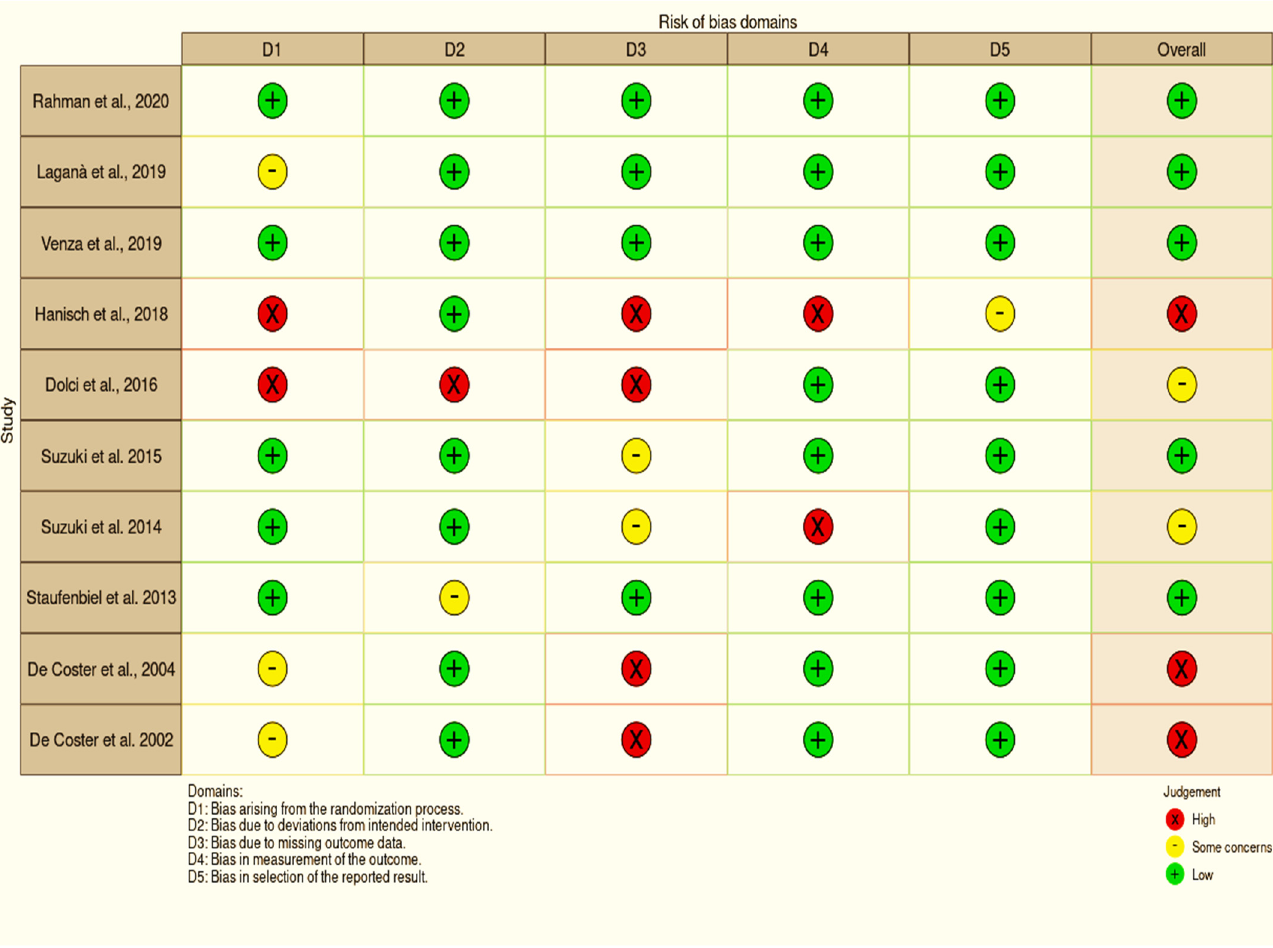
Figure 6. Risk of bias assessment visualization [8,9,17–24].